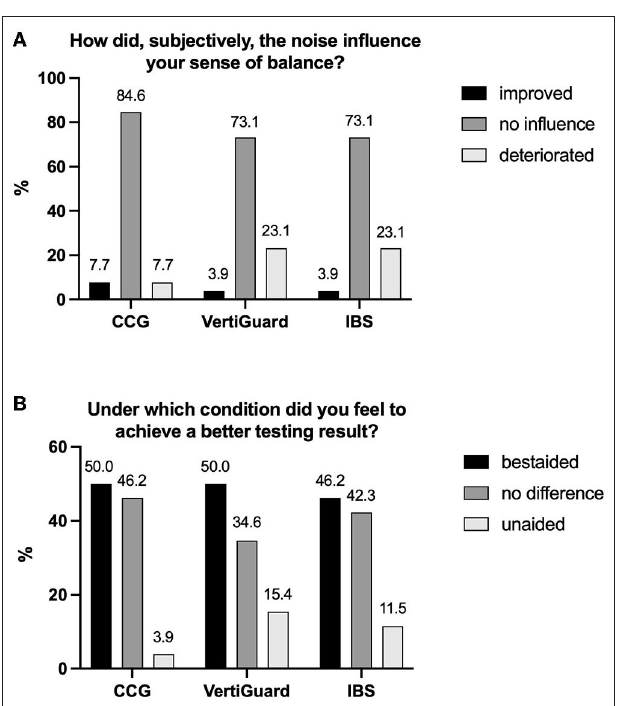
FIGURE 4 | Descriptive illustration of the results of the two questions (A,B) that patients had to answers after each experiment. CCG, cranio-corpography; IBS, Interactive Balance